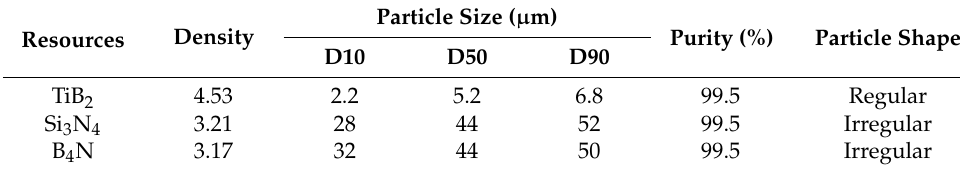
Table 1. Characteristics of the powder elements in their as-received states.